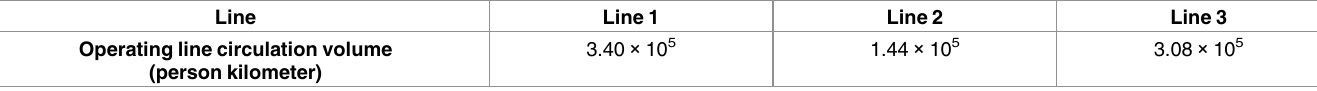
Table 2. Operating line circulation volumes.